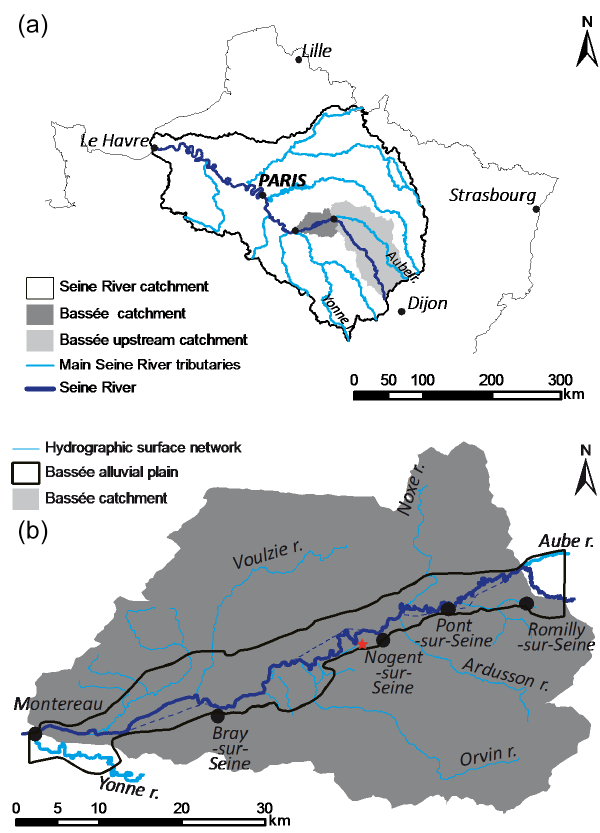
Figure 1. Maps of the Seine catchment (a) and the Bassée alluvial plain (b) .